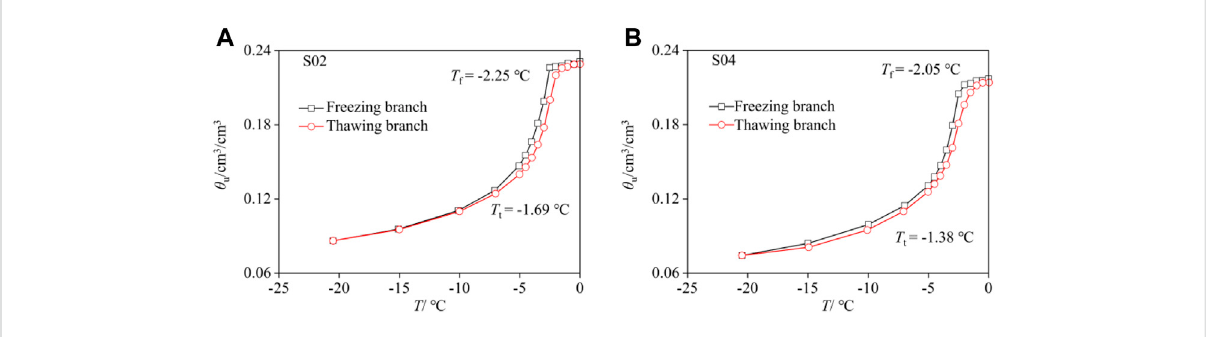
FIGURE 4 Effect of dry density on the SFCC.